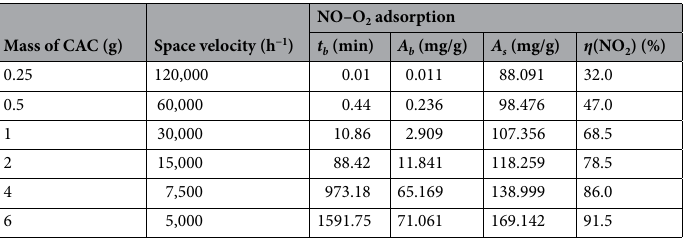
Table 5. Adsorption characteristics of NO-O 2 at various CAC load (NO = 200 ppmv, O 2 = 6 vol.%, T = − 20 ℃ ).